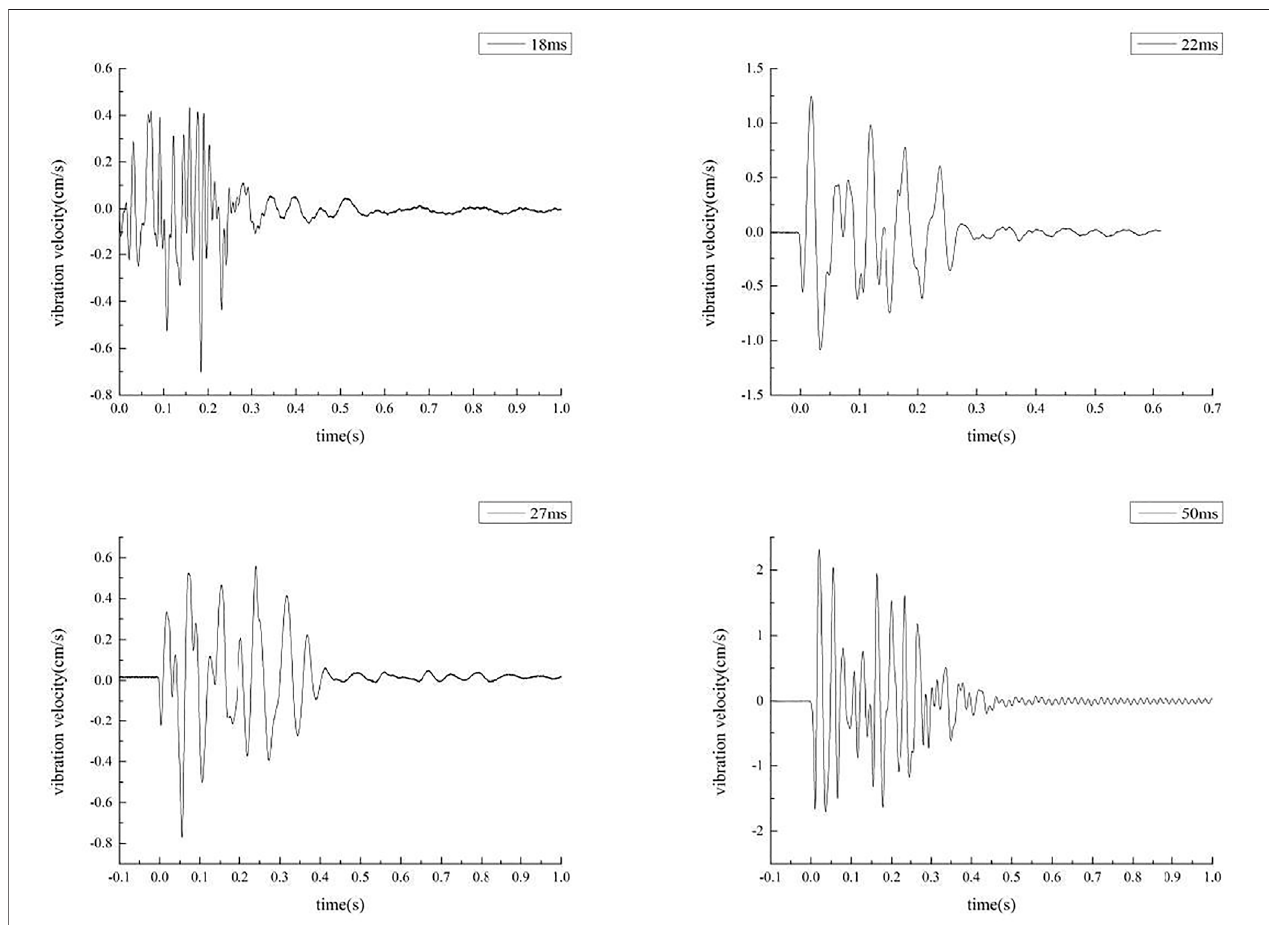
FIGURE 7 | Blasting vibration waveform of M1 at different micro-differences in time.